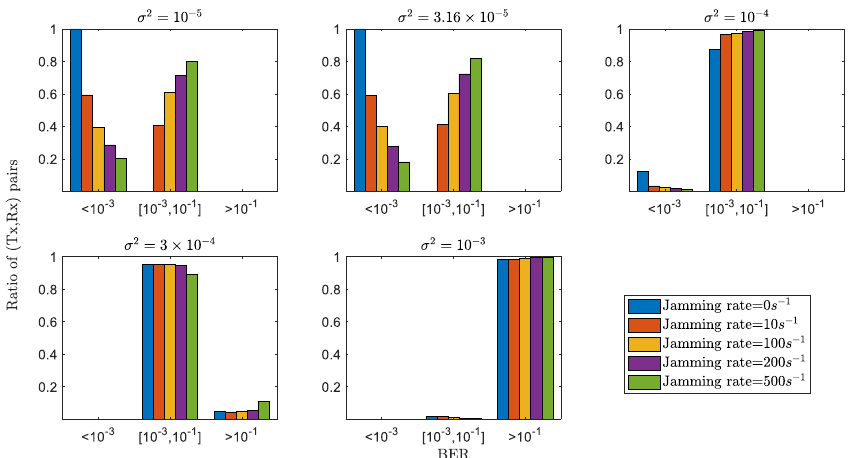
Figure 6. Statistical distribution of all (Tx,Rx) pairs with respect to different levels of BERs with active